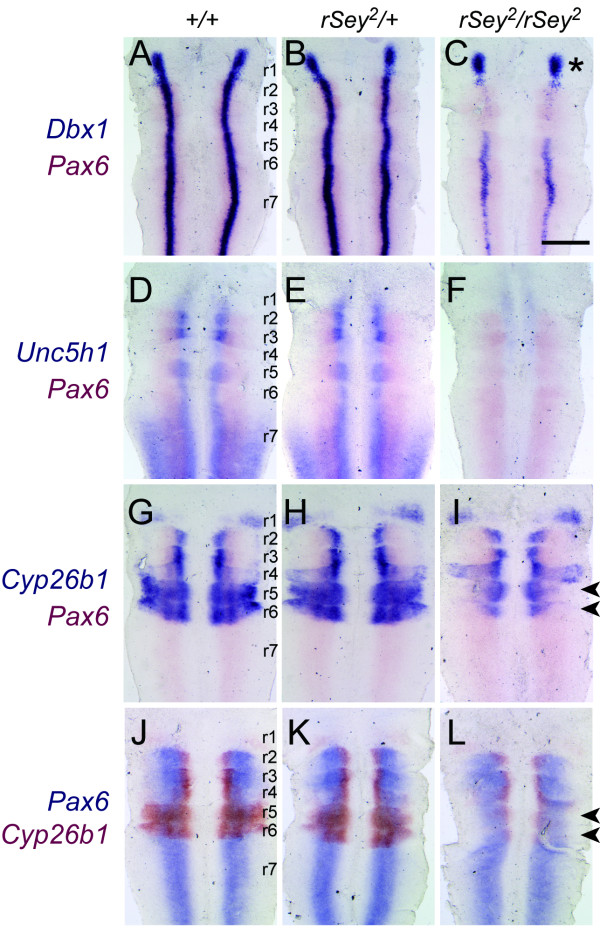
Double in situ staining of mRNAs for down-regulated genes and Pax6 in the E11.5 rat hindbrain. The expression sites of Dbx1, Unc5h1 and Cyp26b1 (blue-violet in A-I and red in J-L) were compared with that of Pax6 (pink in A-I and blue in J-L) in WT (A, D, G, J), rSey2/+ (B, E, H, K) and rSey2/rSey2 (C, F, I, L) hindbrains in 'open-book' preparations. (A-C) Dbx1 expression is decreased throughout the interneuron progenitor domain of the rSey2/rSey2 hindbrain with the exception of r1, where Pax6 is not expressed (asterisk in C). (D-F) Unc5h1 expression disappears in the somatic motor neuron progenitor domain and in the dorsal region of r7 in the rSey2/rSey2 hindbrain (F). (G-L) Cyp26b1 expression is specifically altered in the dorsolateral region of r5 and r6 in the rSey2/rSey2 hindbrain (arrowheads in I and L). r1 to r7 indicate the individual rhombomeres of the hindbrain. Scale bar: 500 μm.